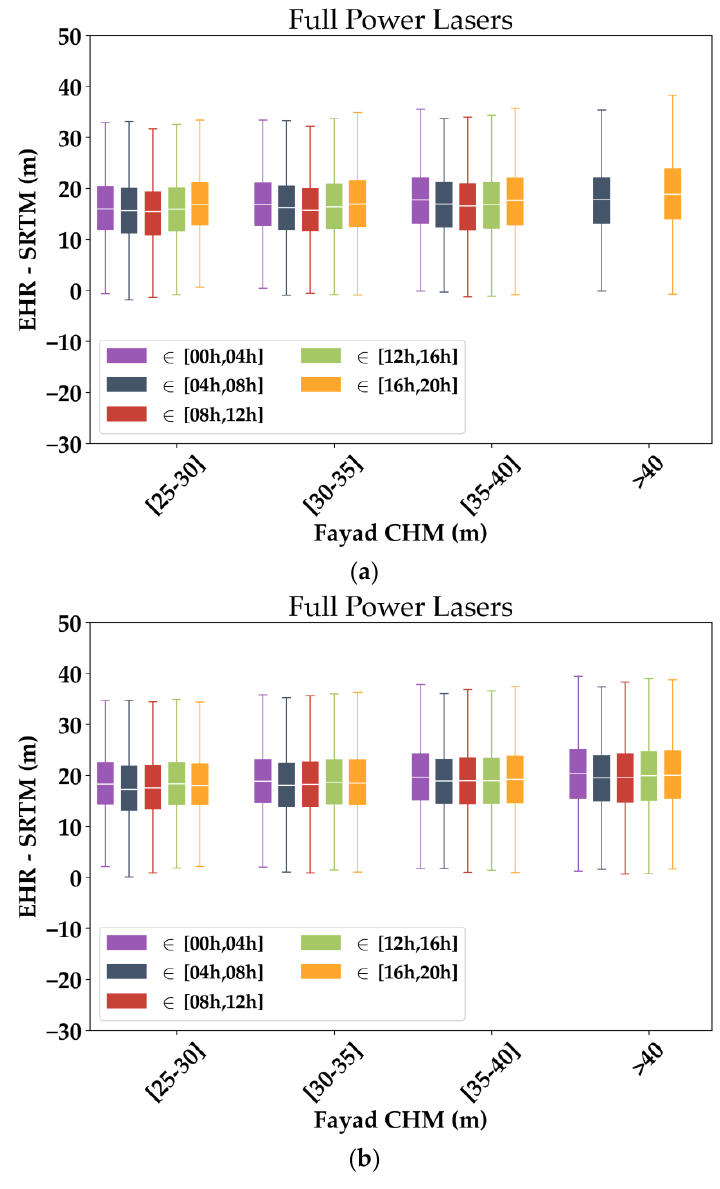
Figure 11. Boxplots of the difference between the elevation of each waveform’s highest return (EHR) and SRTM from GEDI’s coverage ( a ) and full-power lasers ( b ) as a function of acquisition time. Only acquisitions with beam sensitivity ≥ 98% were used. The lack of boxplots in ( a ) corresponds to the insufficiency of available data in the corresponding time ranges.